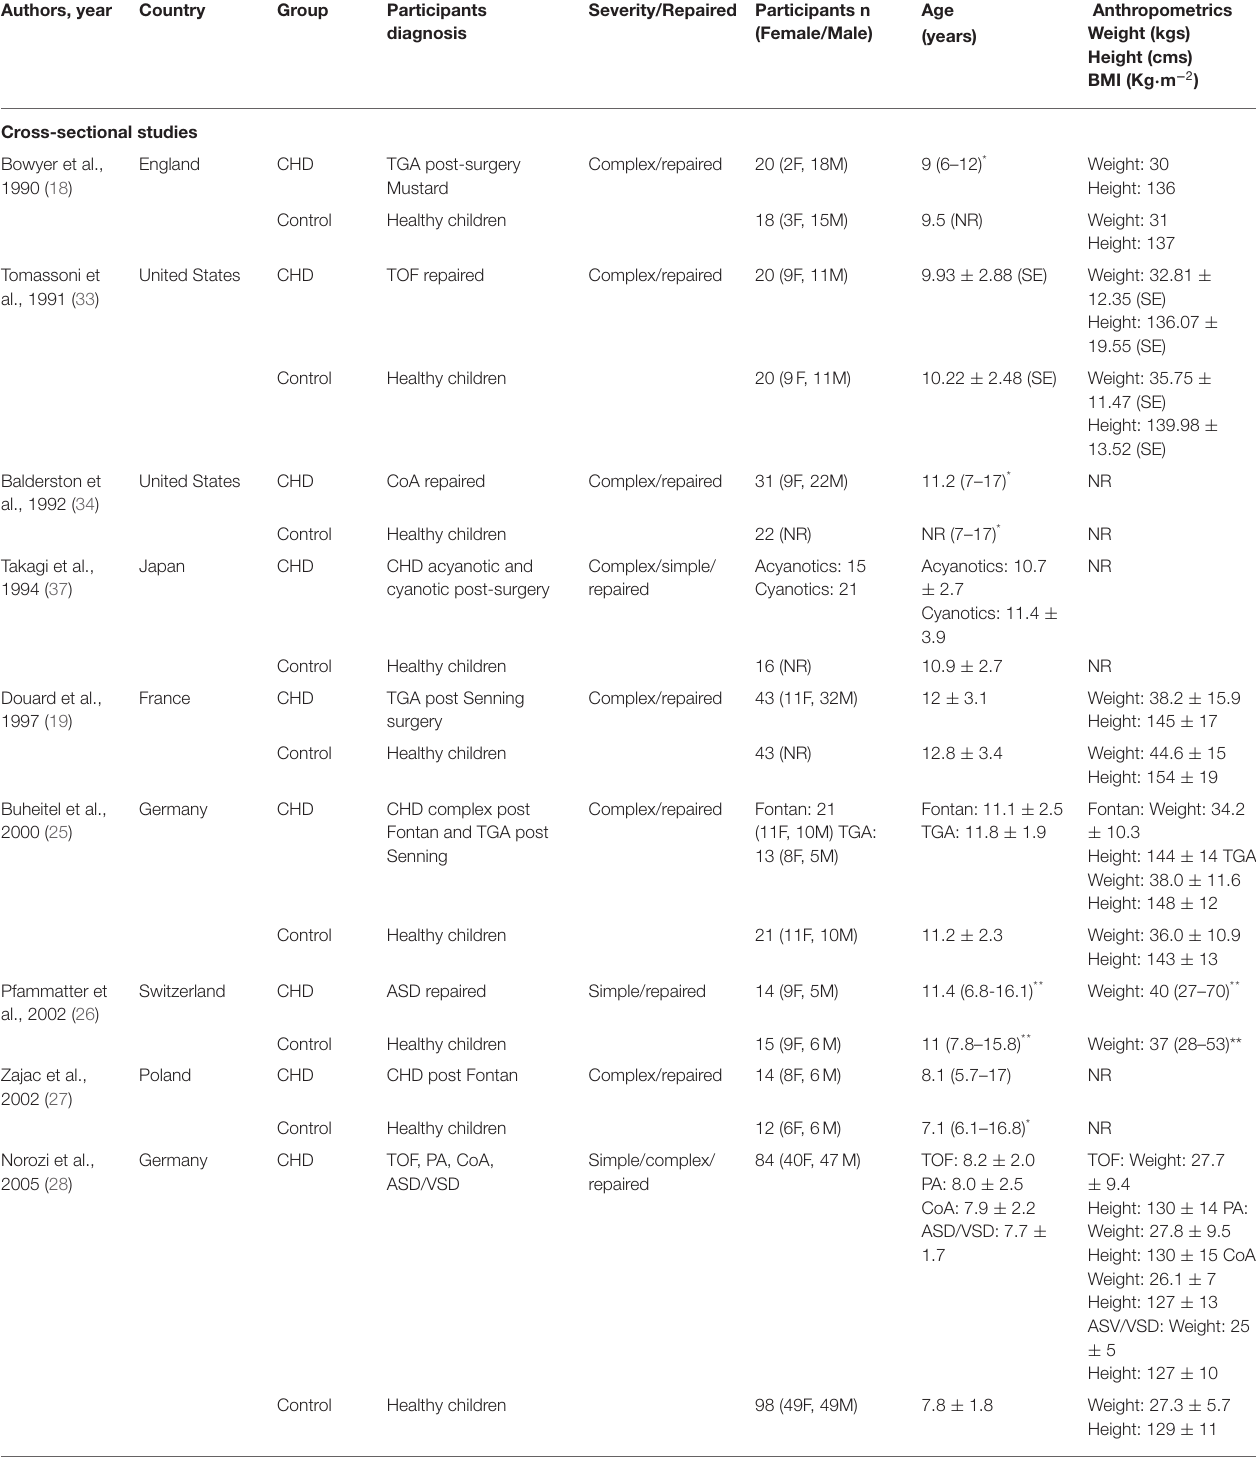
TABLE 1 | Characteristics of the included